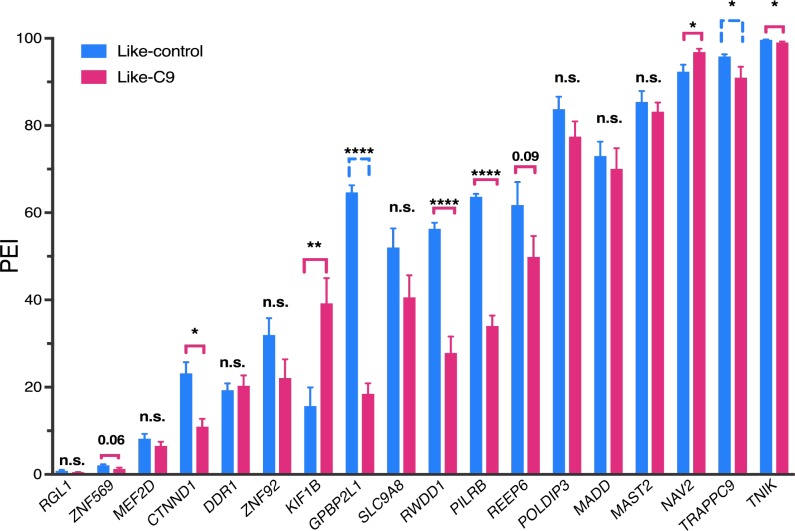
Quanitification of TDP-43 splicing targets.Summary quantification of rt-PCR of 18 TDP-43 splicing targets with six most like-control (highest CSS) and six most like-C9 (lowest CSS) patients. Signifcant events, using a more permissive cutoff (p<0.10, t test) are indicated with a bracket that is pink if the direction of change indicates TDP-43 LOF in like-C9, or blue and dashed if the direction of change indicates TDP-43 LOF in like-control. (p value: *=0.05, **=<0.01, ***=<0.0001, ****=<0.0001; values between 0.05 and 0.10 are displayed numerically).